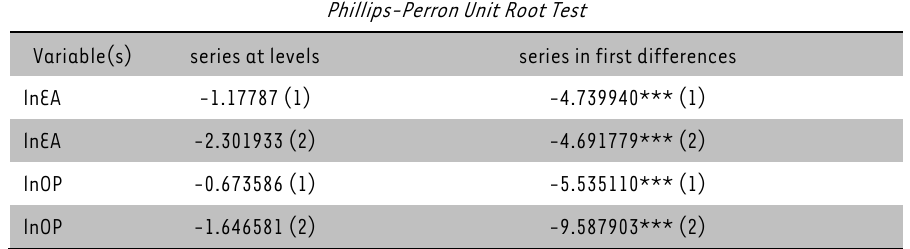
TABLE 2: PP Unit root test